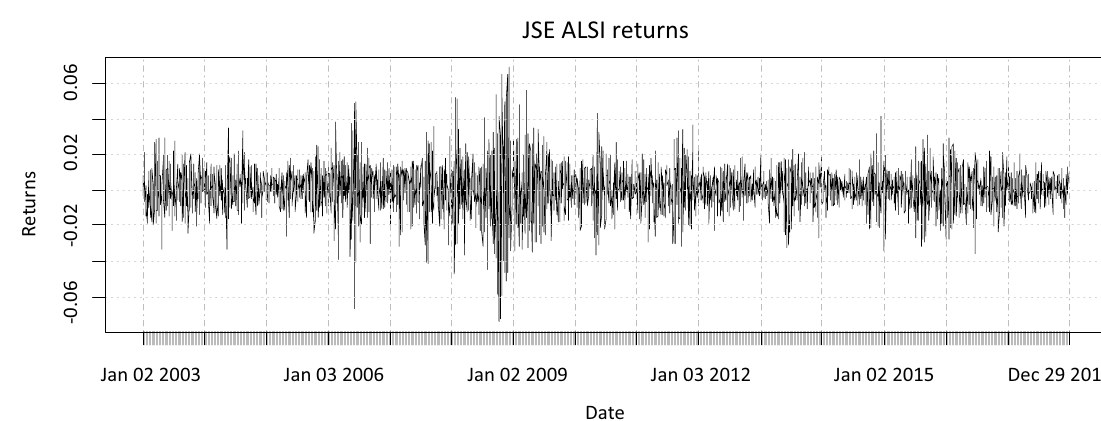
Figure 1. Trend of JSE All-Share Index over the period January 2003 – December 2017